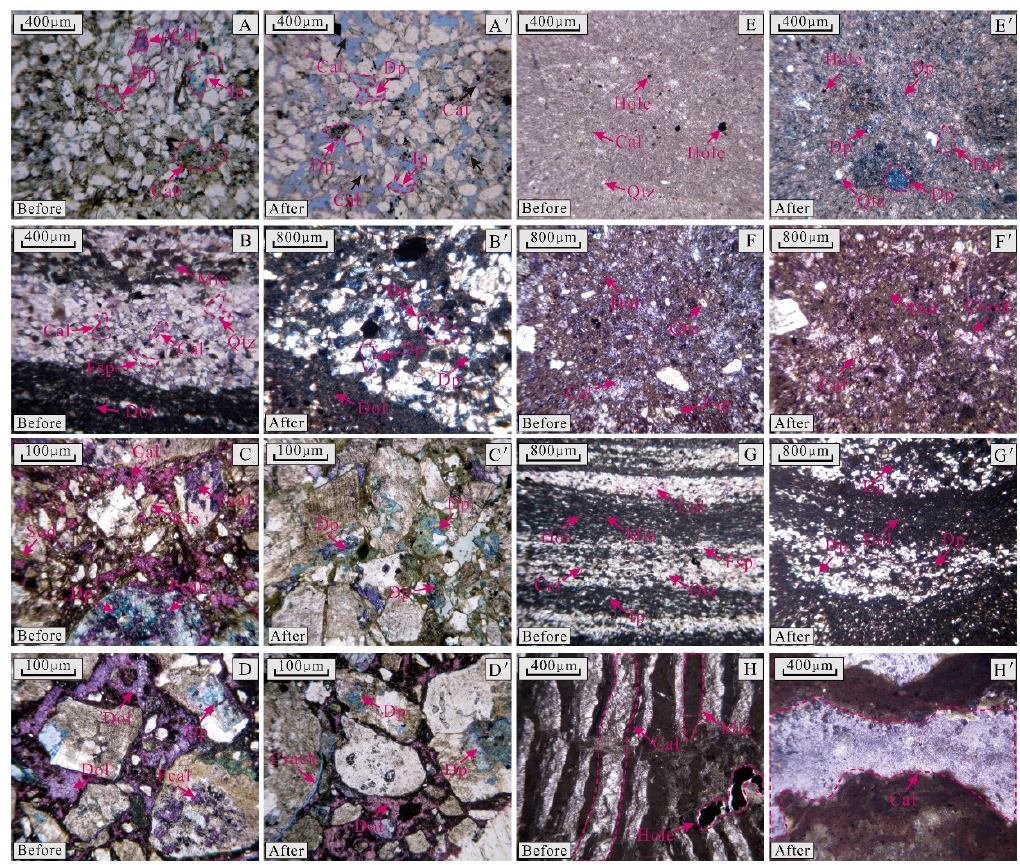
Figure 4. The photomicrographs showing the pore structure characteristics of the selected samples before and after acidification. ( A – H ) Samples before acidification; ( A' – H' ) Samples after acidification. Dol—Dolomite; Mic—Micrite; Kfs—K-feldspar; Sod—Superficial ooid; Cal—Calcite; Idp— Intragranular dissolution pore; Dp—Dissolution